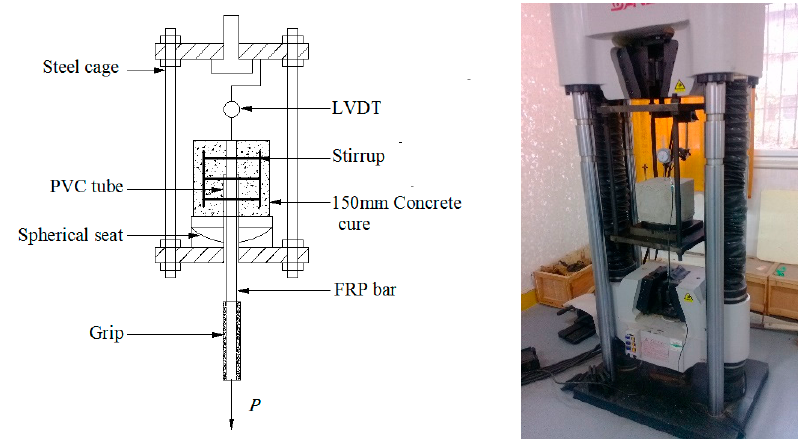
Figure 4. Pullout test setup.